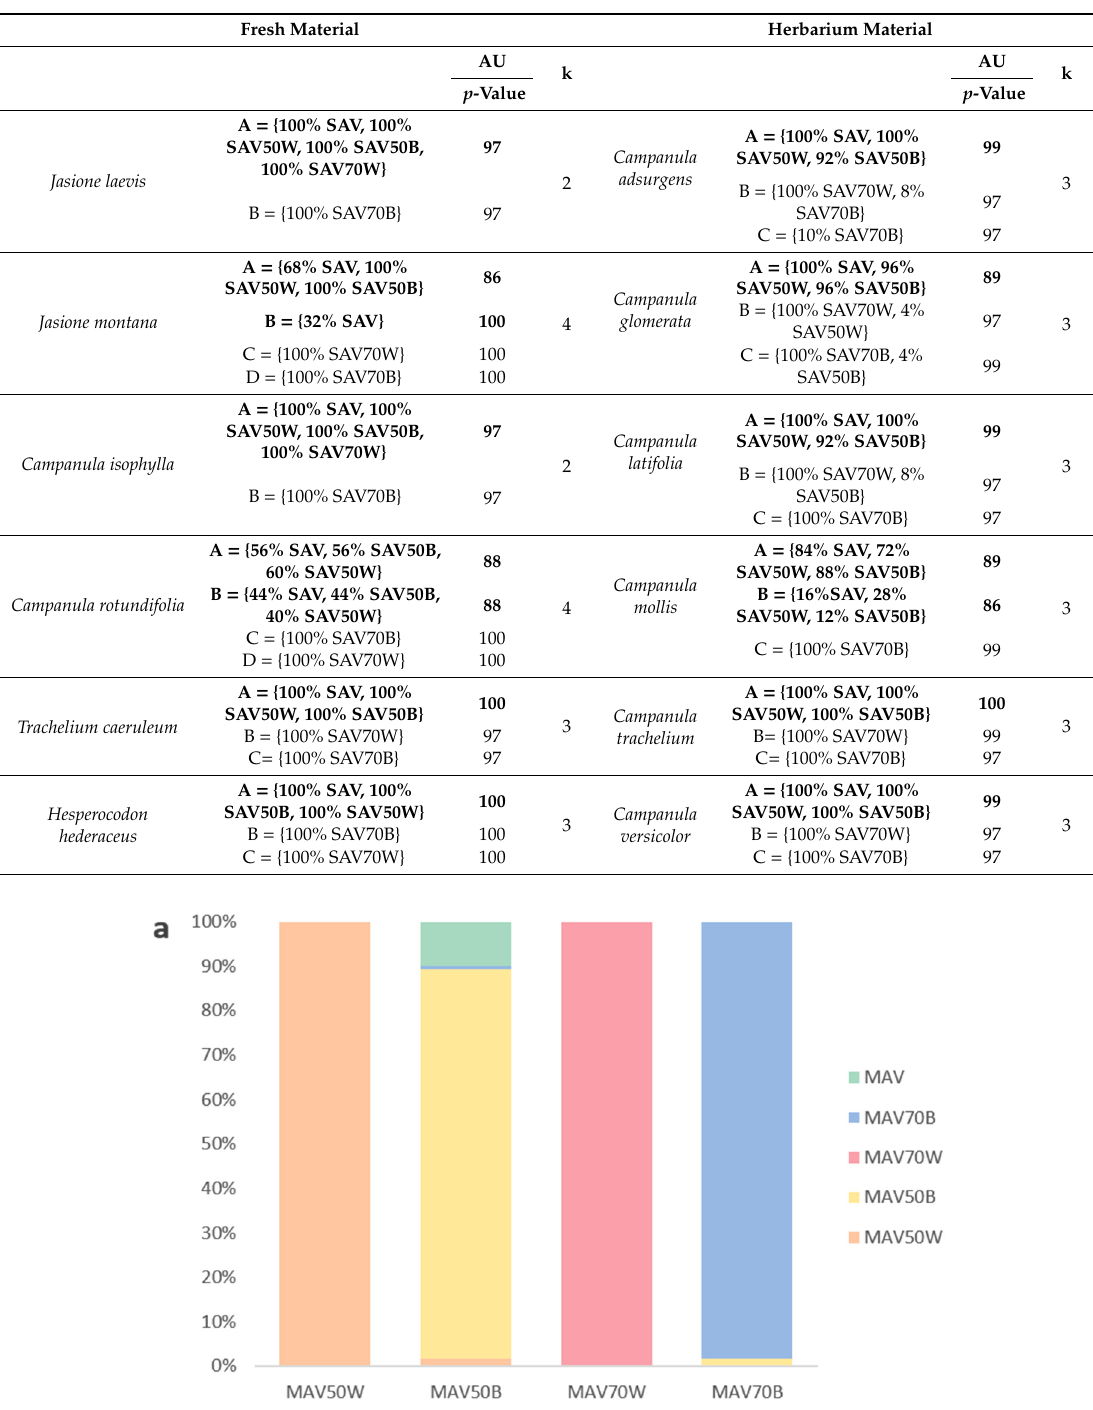
Table 3. Results of the k-means cluster analysis on SAV measurements with the di ff erent adaptors compared to no adaptor. The number of clusters formed ( k ) and the related approximately unbiased (AU) p-values are indicated for each k-cluster. Clusters with AU p -value equal to or greater than 95% are considered strongly supported by data. The clusters where the SAV measurements with no adaptor (real color) fall are indicated in bold.